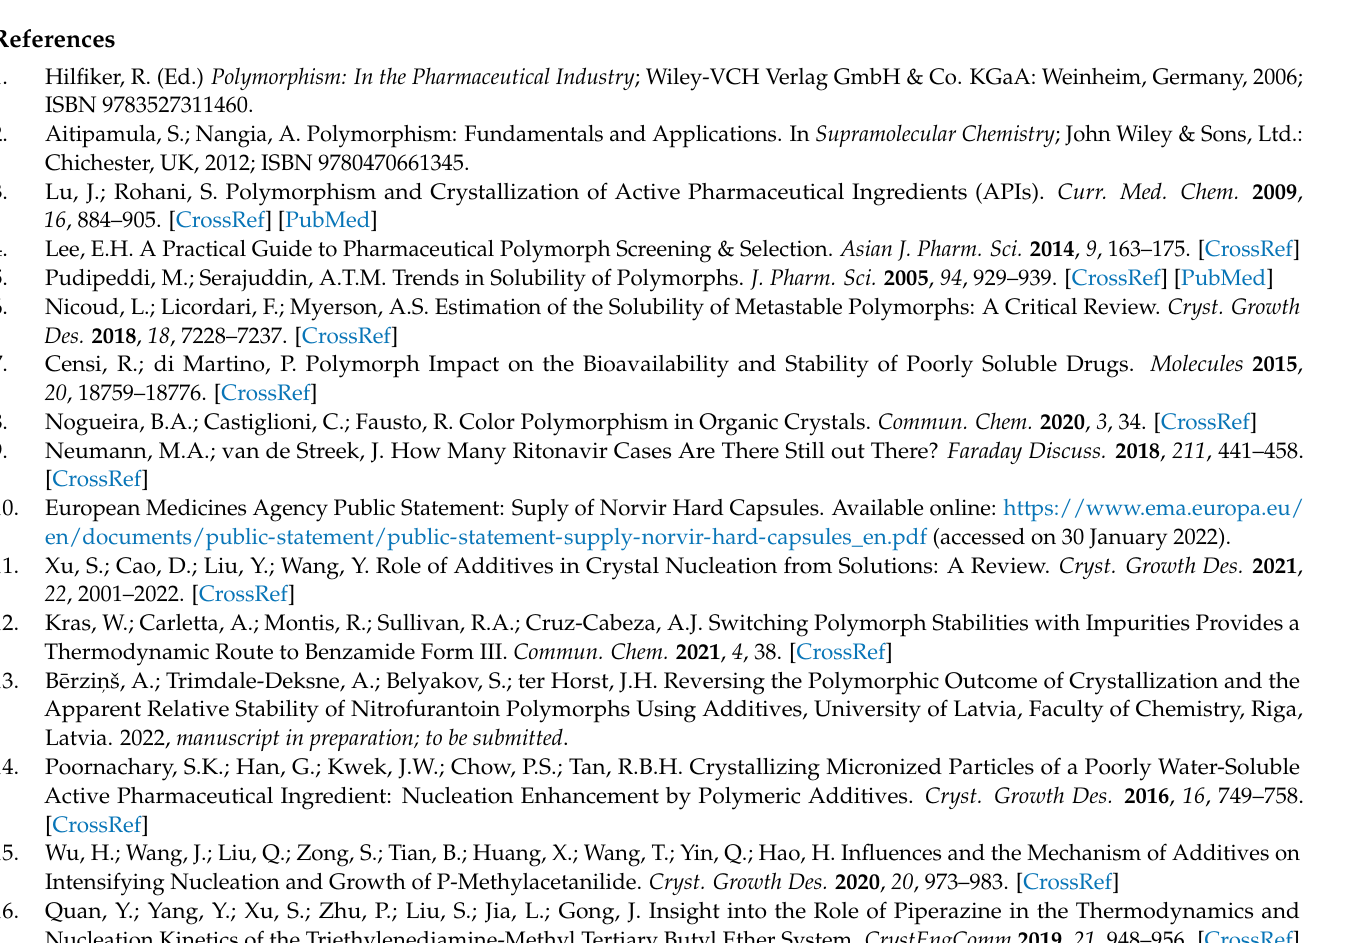
MPBA Form III; Figure S8: Results of the crystallization in the presence of additives from toluene and water; Table S6: Intramolecular energies and torsion angle data of MPBA polymorphs; Figure S9: FIMs combined on the BFDH morphology of MPBA polymorph I using different crystal structure models. Author Contributions: Investigation, writing—original draft preparation and visualization, A.S.; Conceptualization, methodology, and writing—review and editing, A.S. and A.B.; Supervision, A.B. All authors have read and agreed to the published version of the manuscript. Funding: This research was funded by the European Social Fund and the Latvian State budget project “Strengthening of the capacity of doctoral studies at the University of Latvia within the framework of the new doctoral model”, identification No. 8.2.2.0/20/I/006. Data Availability Statement: No new data were created or analyzed in this study. Data sharing is not applicable to this